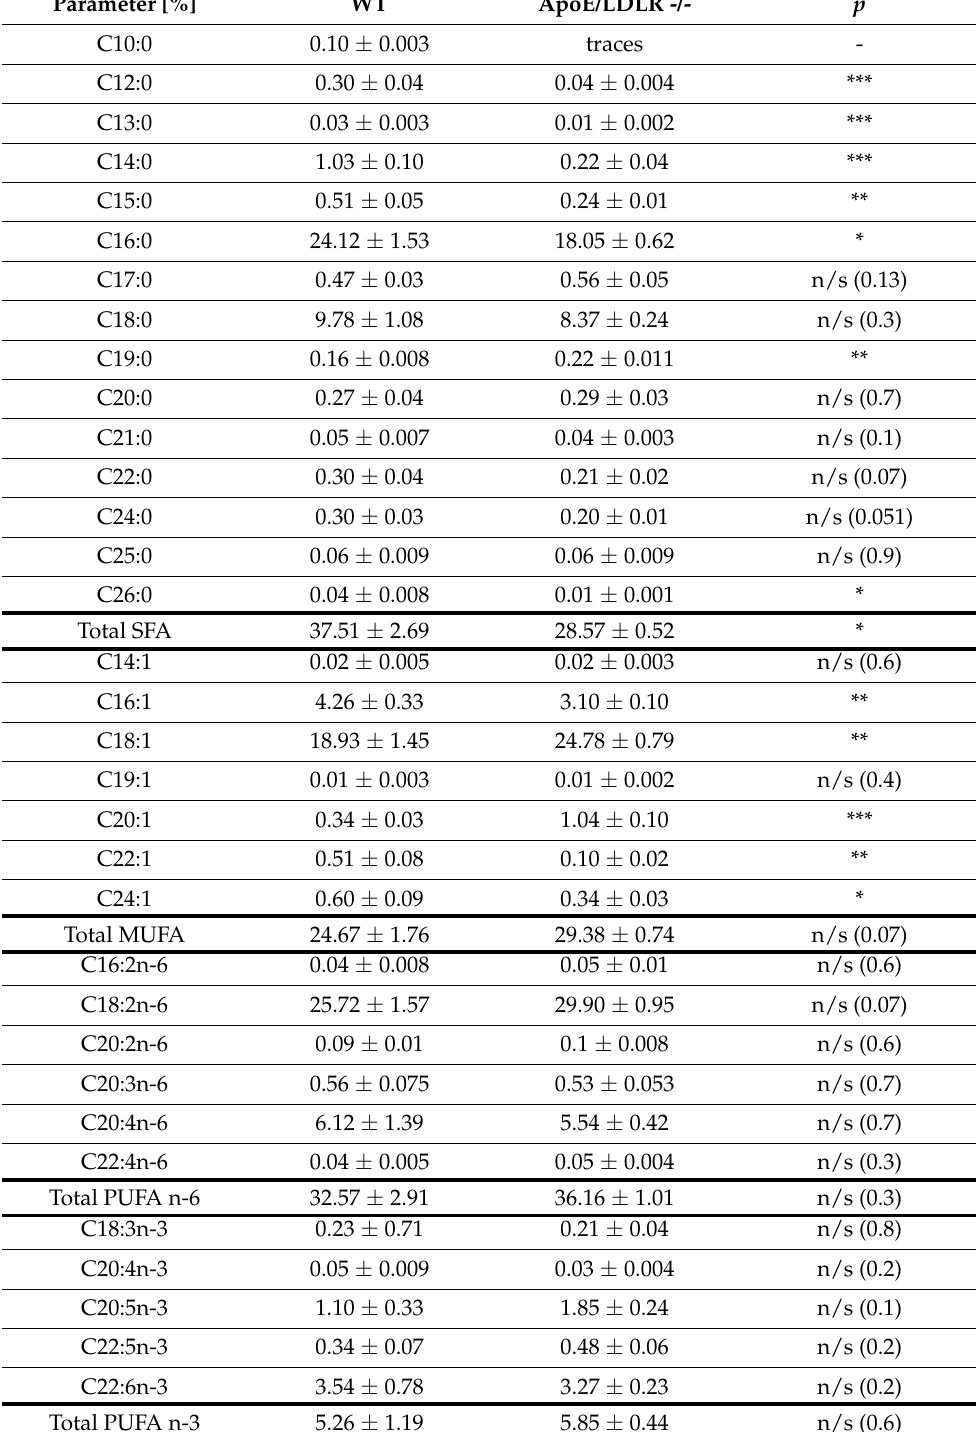
Table 1. Reduced saturated fatty acids and increased monounsaturated fatty acids content in ApoE/LDLR -/- mice serum. Results presented as mean ± SEM, n = 6, * p < 0.05, ** p < 0.01, *** p <